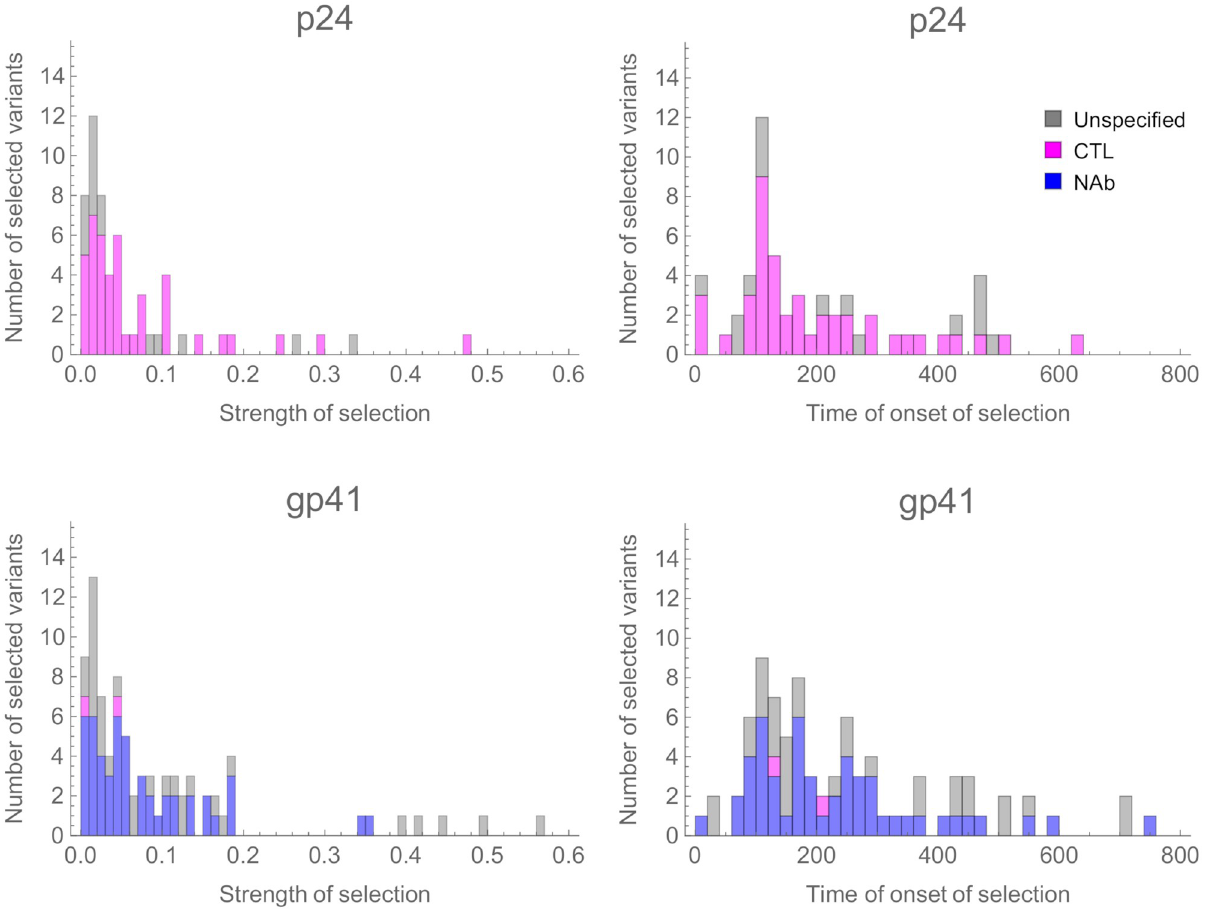
Fig 2. Histograms of inferred strengths of selection and times in days of onset of selection across 34 individuals. The maximum likelihood estimates are shown in each case, for the subset of the data where the upper and lower bound confidence intervals on the strength of selection are within an order of magnitude of each other. Bars indicate variants at nucleotide sites, and are coloured according to whether they are within AA positions associated with differences in susceptibility to CTLs (pink) or susceptibility to NAbs (blue). Where a codon is implicated in both a NAb and CTL response, for clarity it is coloured blue (see S2